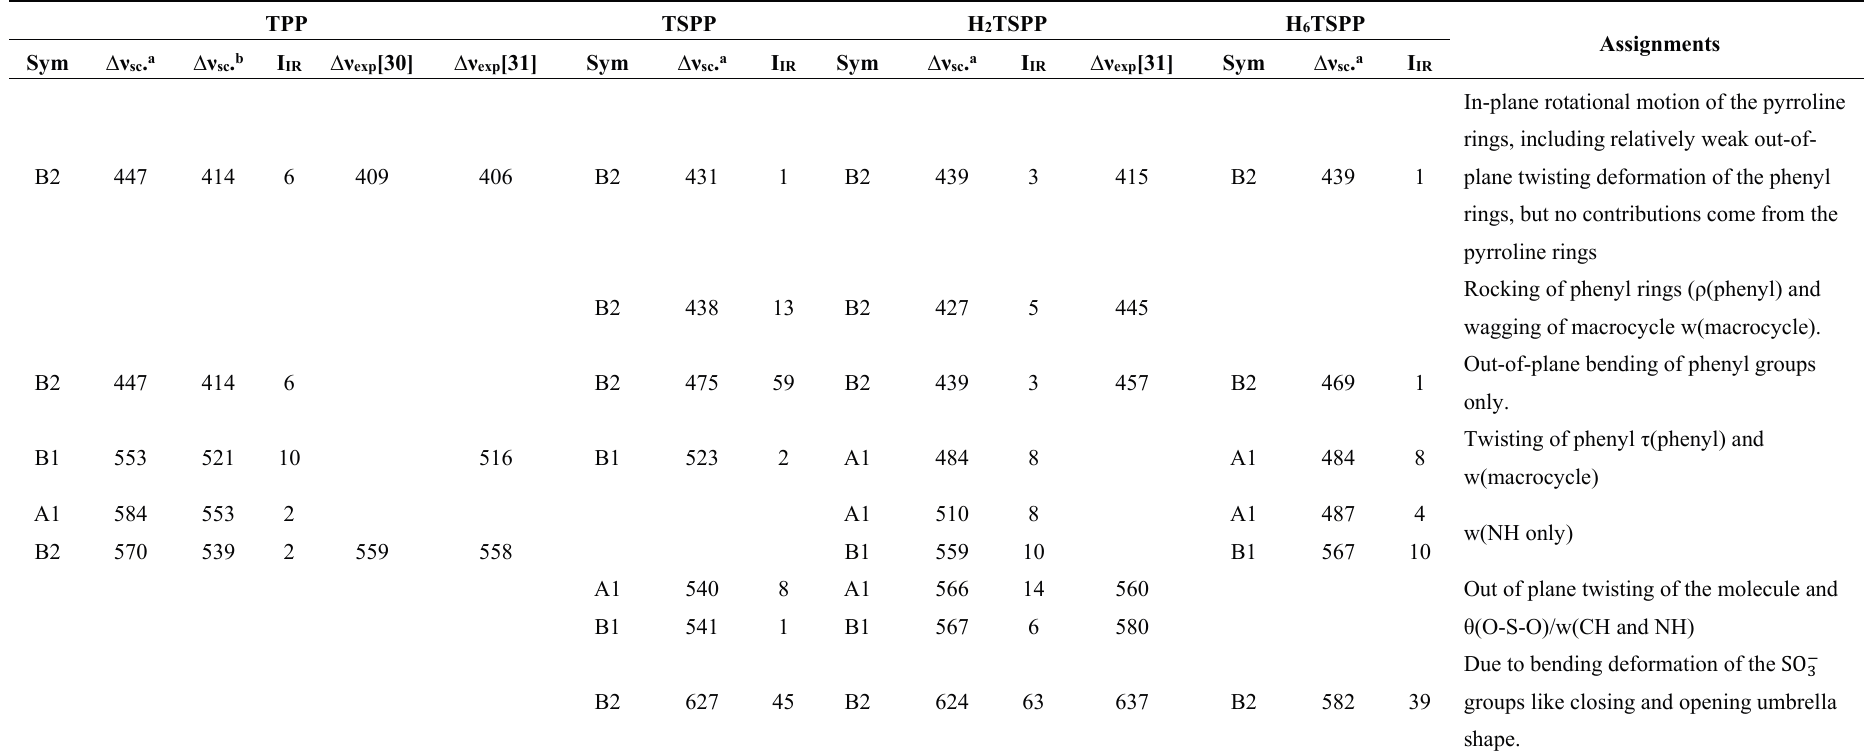
Table 4. Assignments of the IR active modes of frequencies (in cm − 1 ) of the meso substituted porphyrin derivatives: TPP (C 2v point group), TSPP (C 2v ), H 2 TSPP (C 2v ) and H 6 TSPP (C 2v ) for comparison. The calculations were carried out in water used as solvent at